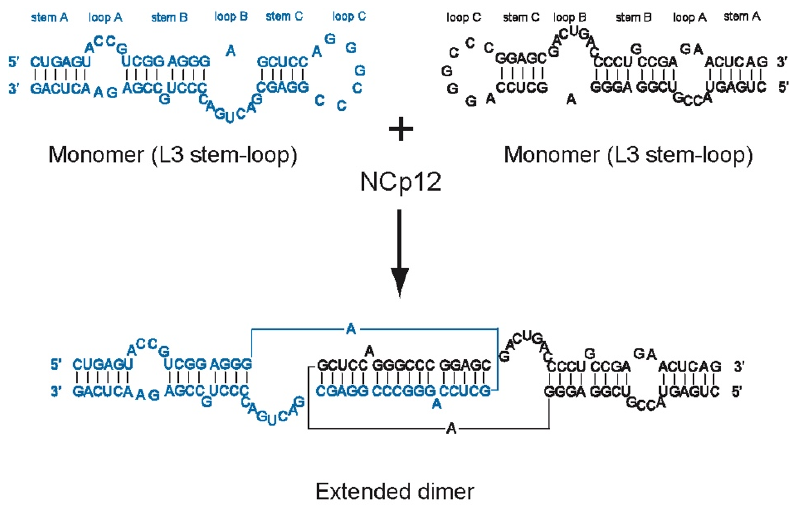
Figure 2. Secondary structures for the L3 stem-loop in the monomer and the extended dimer.